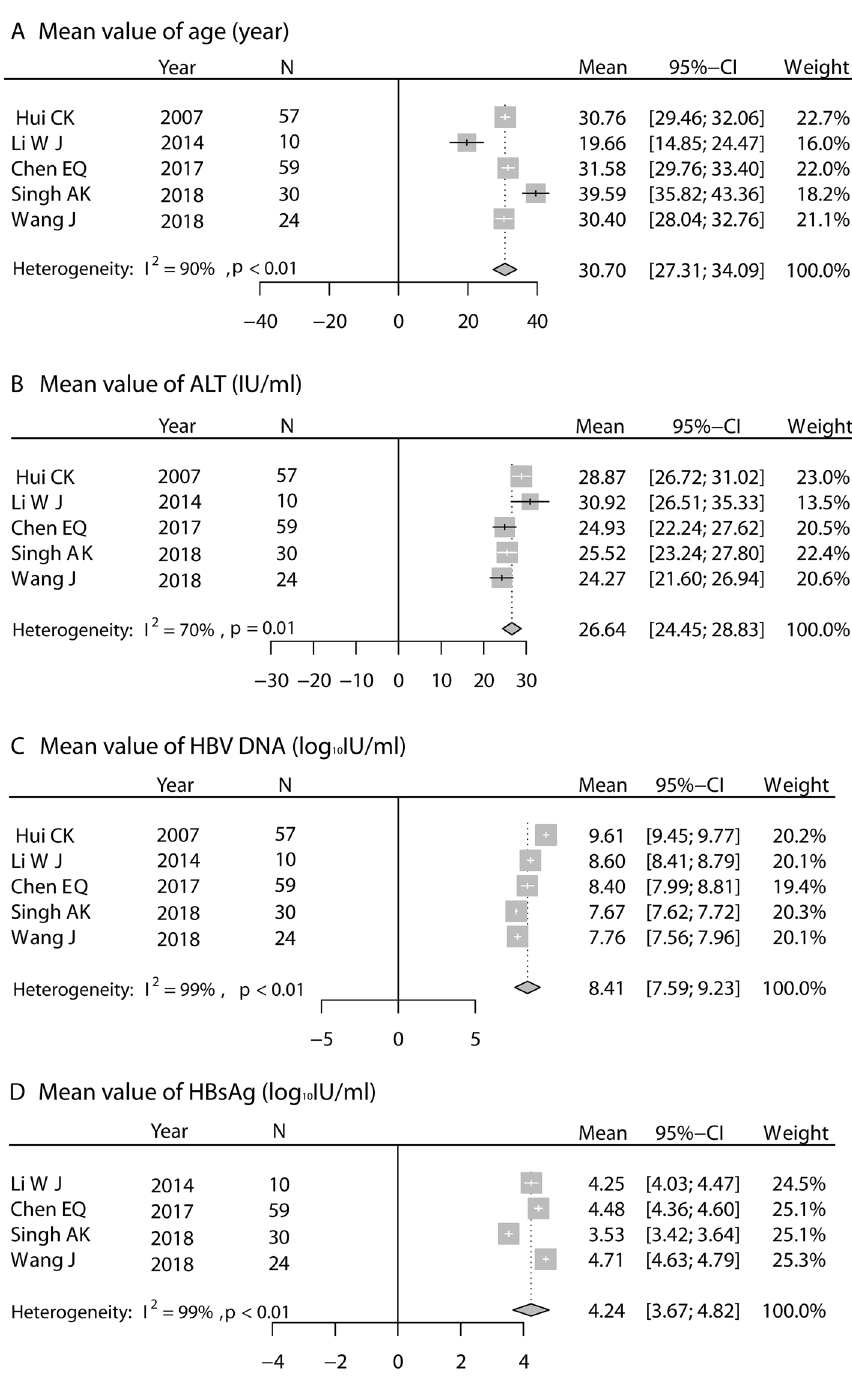
Figure 3. Pooled mean values of main characteristics among IT patients diagnosed by dual